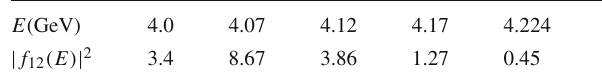
Table 6 The values of the | f 12 ( E ) | 2 near the channel thresholds for the transition